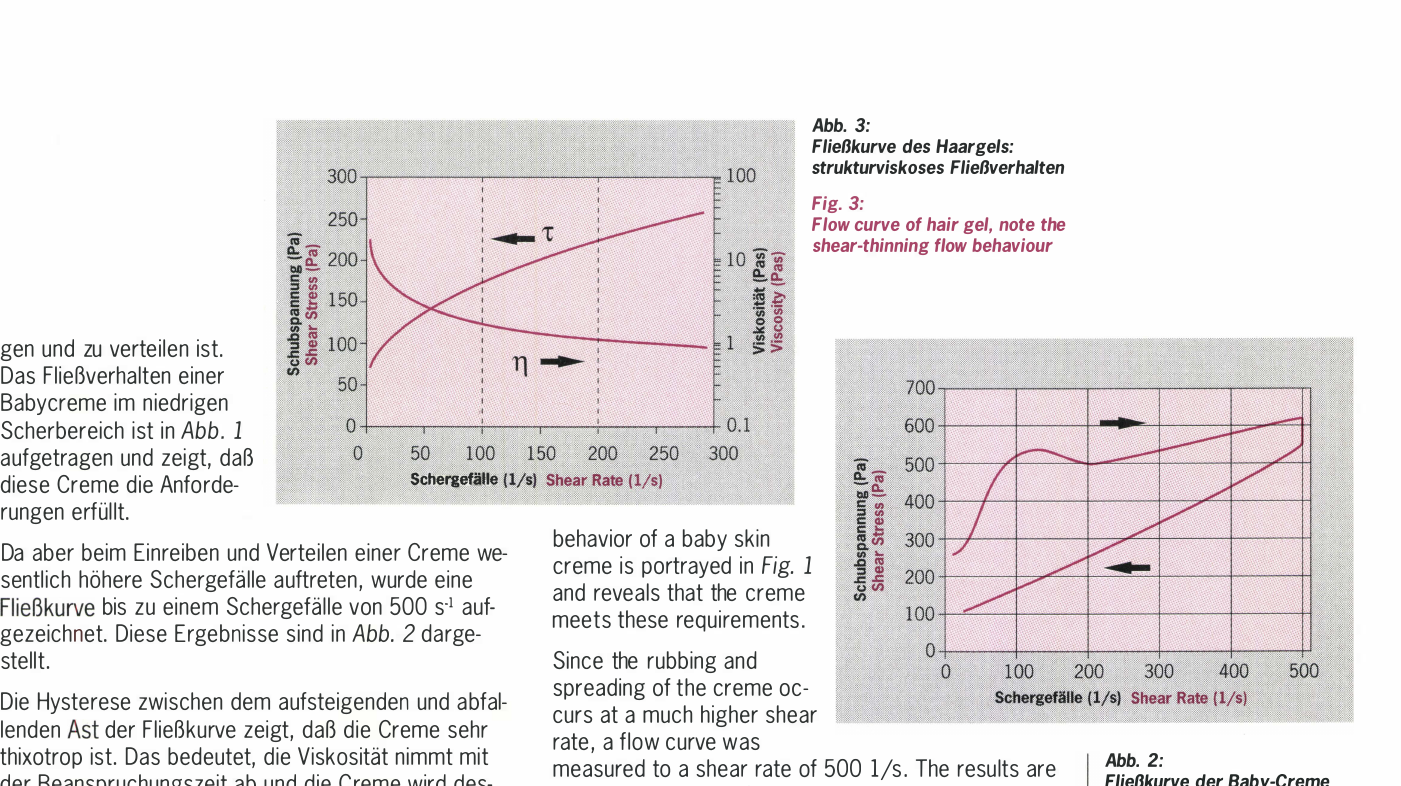
Fig. 2: Flow curve of the baby creme at higher shear